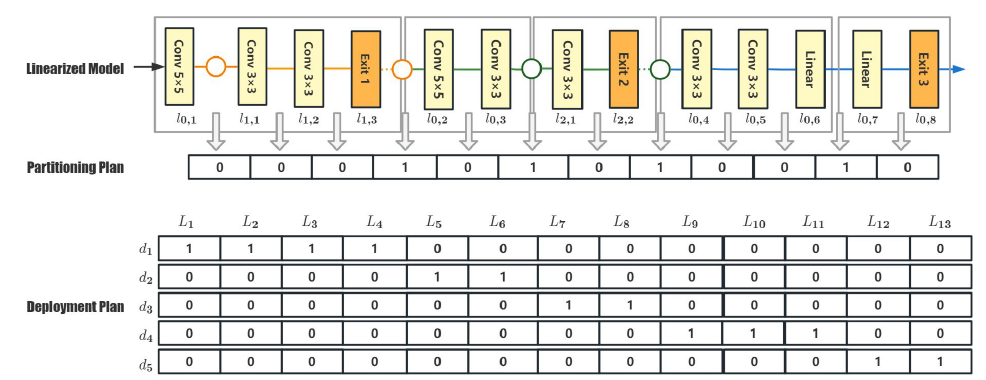
Figure 3. An example of relationship among a linearized BranchyNet, a partitioning plan, and a deployment